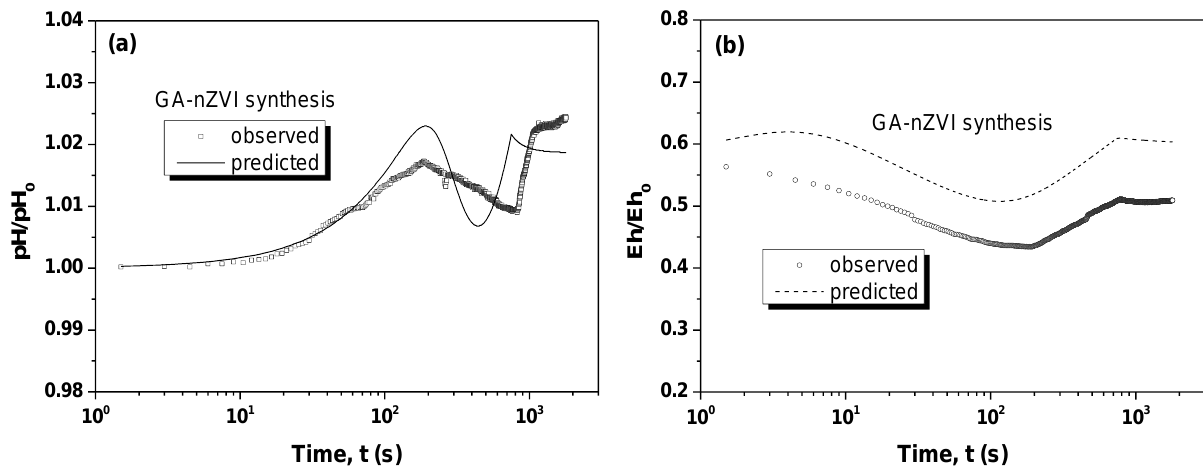
Figure 11. Comparison of experimentally measured with numerically predicted (a) pH/pH0, and (b) Eh/Eh0, when ferrous ions are reduced to zero valent iron by the Gallic Acid (GA-nZVI).